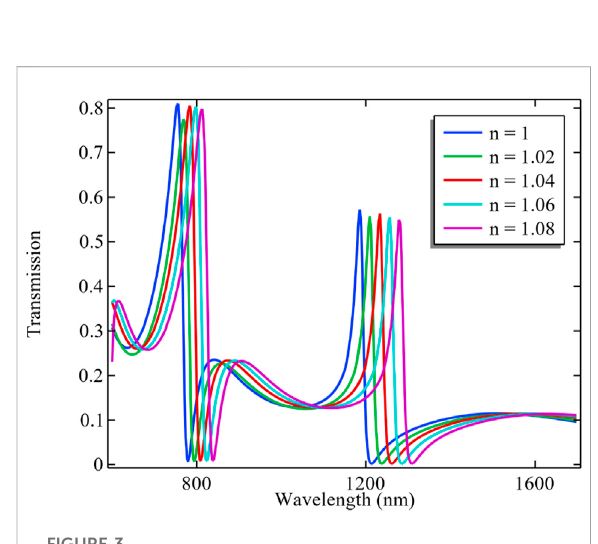
FIGURE 3 Transmission spectrum as a function of refractive index